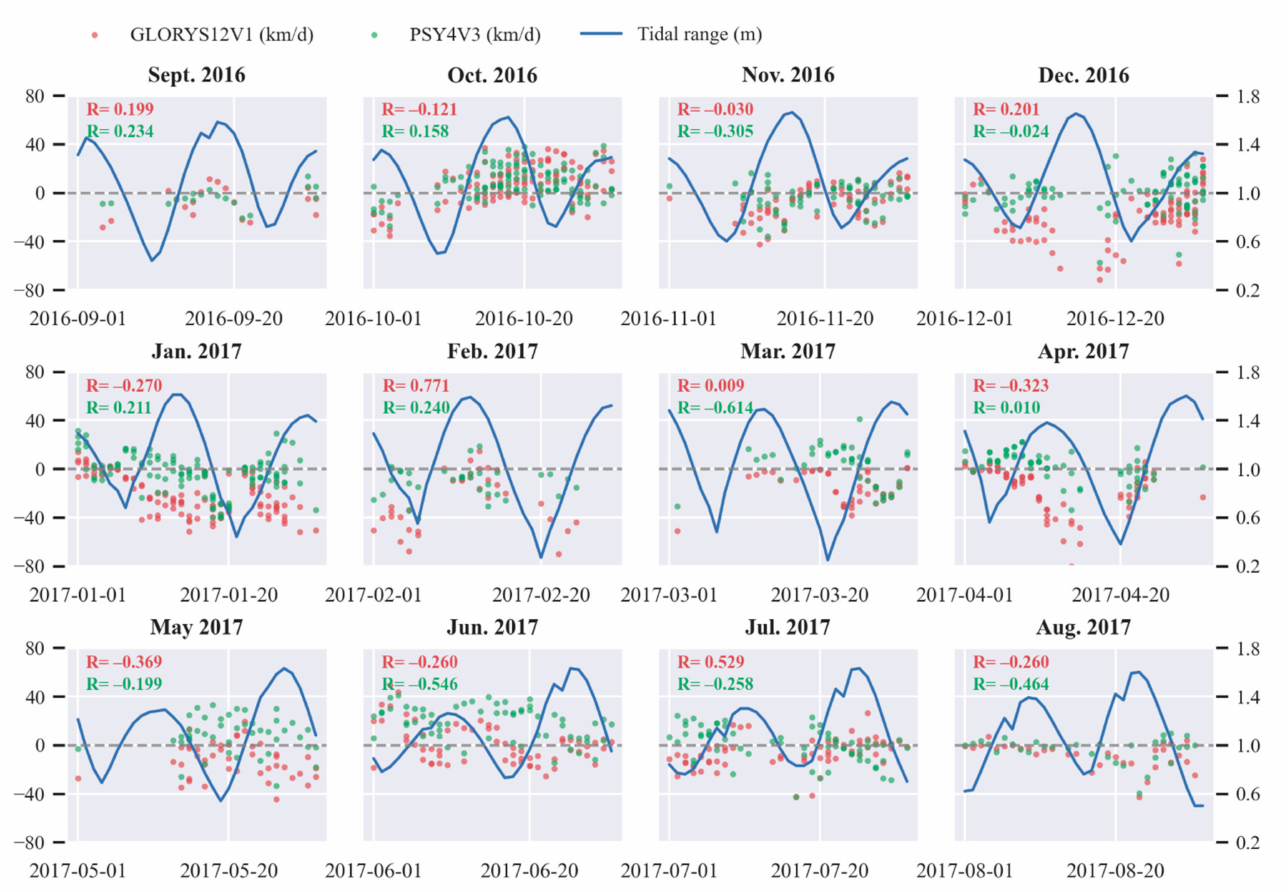
Figure 12. Daily tidal range and deviation between the sea ice motion products and the ice floe speed from Sentinel-1 images inside the Robeson Channel